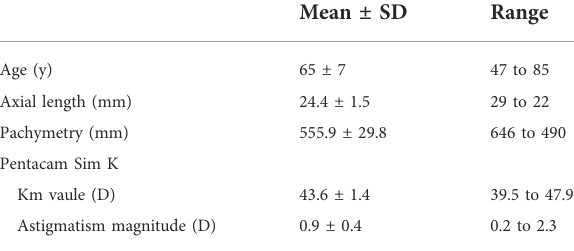
TABLE 1 Preoperative patient characteristics and biometric parameters.